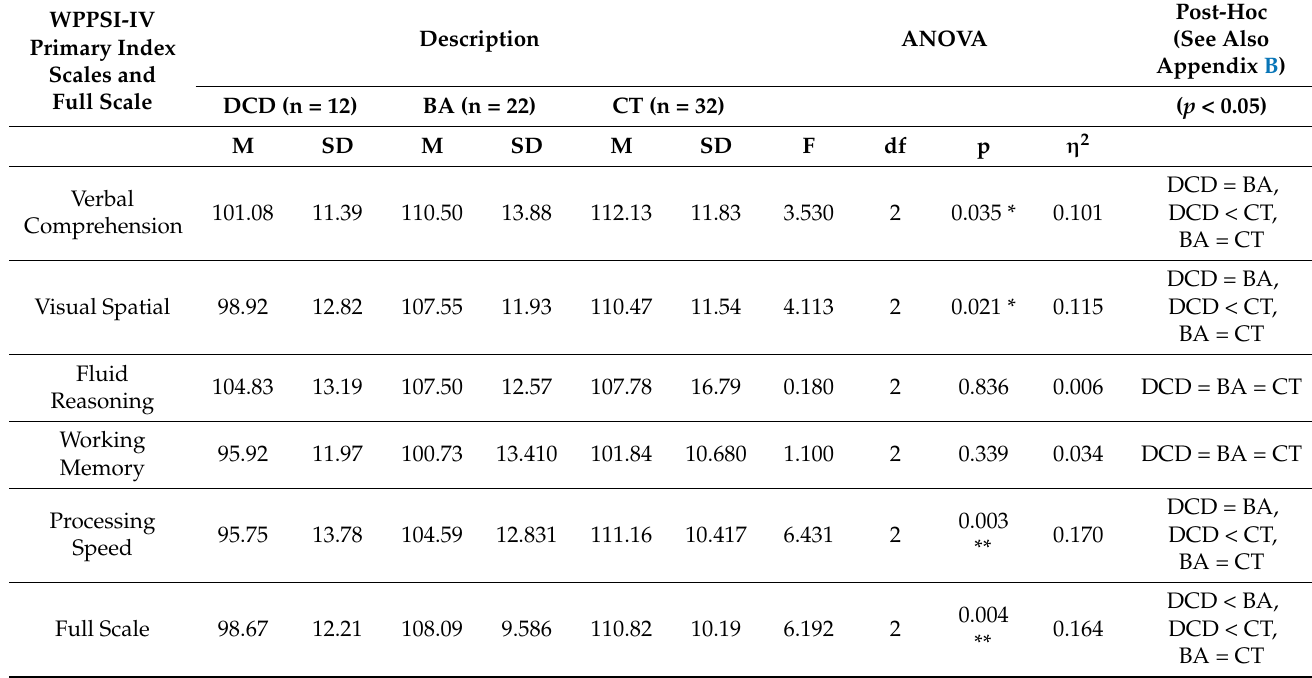
Table 2. Descriptive statistics and characteristic values of the one-factor ANOVA for the primary WPPSI-IV index scores (IQ